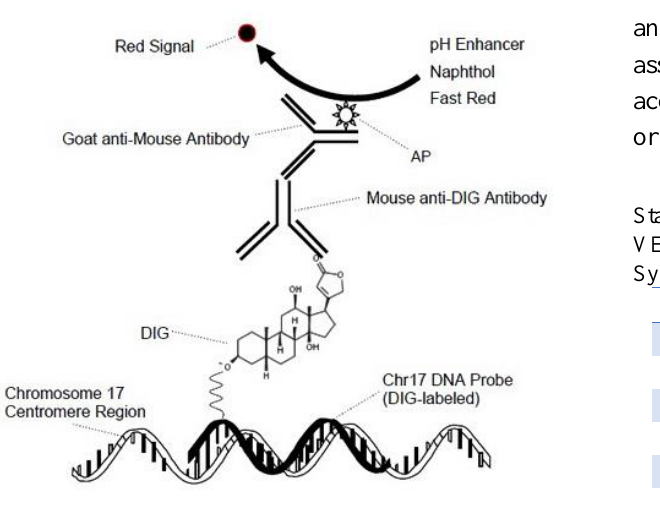
Fig. 3. Red In Situ Hybridization Reactions for Chromosome 17 DNA Detection